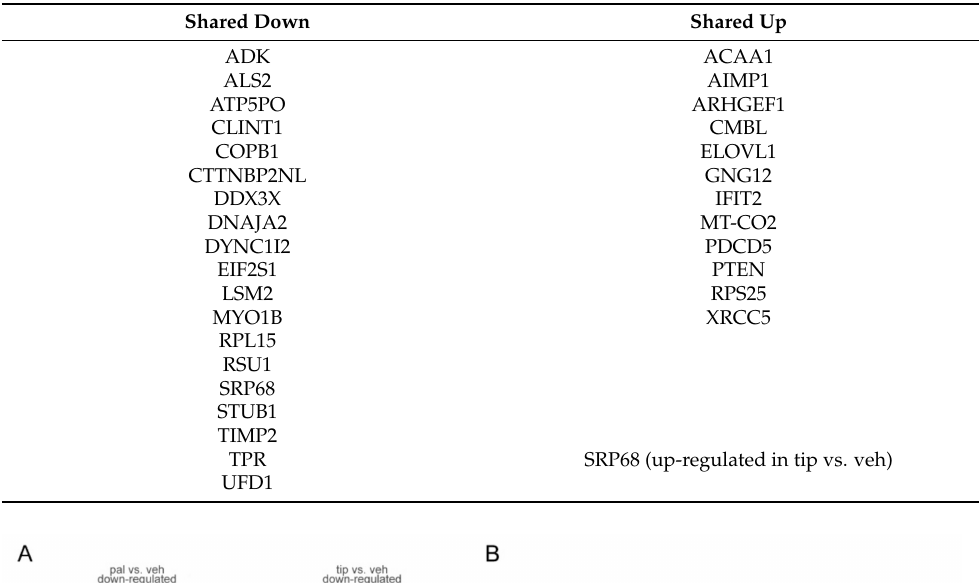
Table 1. Shared proteins of treatments compared with the control.